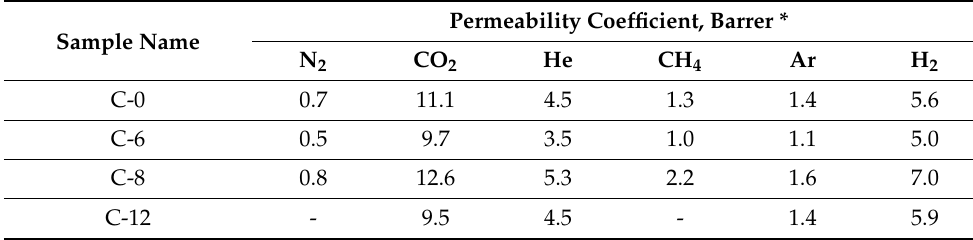
Table 3. Gas permeability of the obtained composite